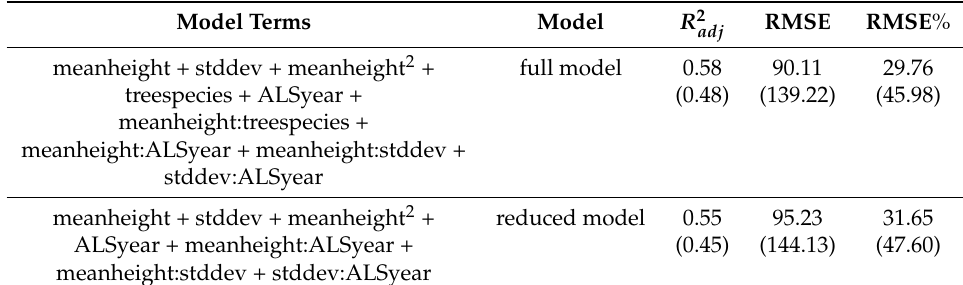
Table 4. Model fit specifications for the two OLS regression models on the cluster level. Interaction terms are indicated by ’:’. () give the respective values on the plot level.